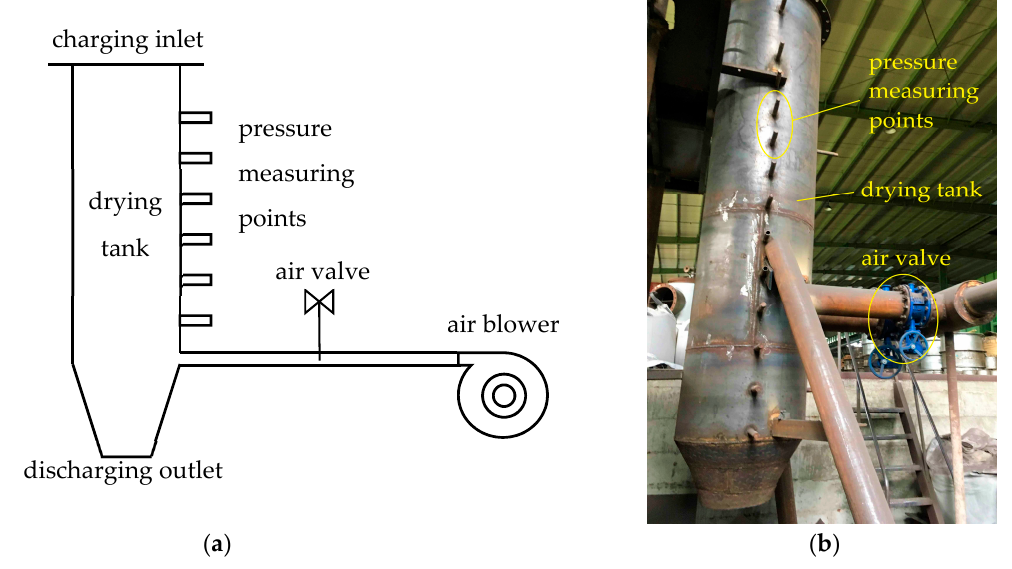
Figure 4. Apparatus for pressure drop experiment: ( a ) Conceptual scheme; ( b ) Real apparatus.